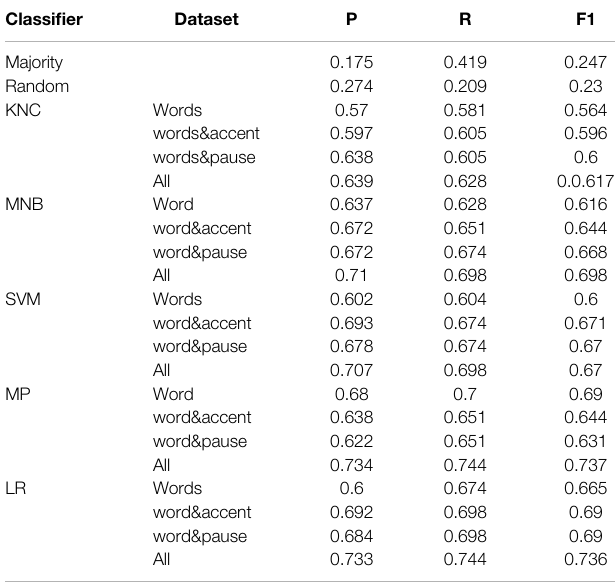
TABLE7| Resultsofclassi fi erspredictingthereferenttypeofabstractanaphorsin the DanPASS dialogues. Classi fi er